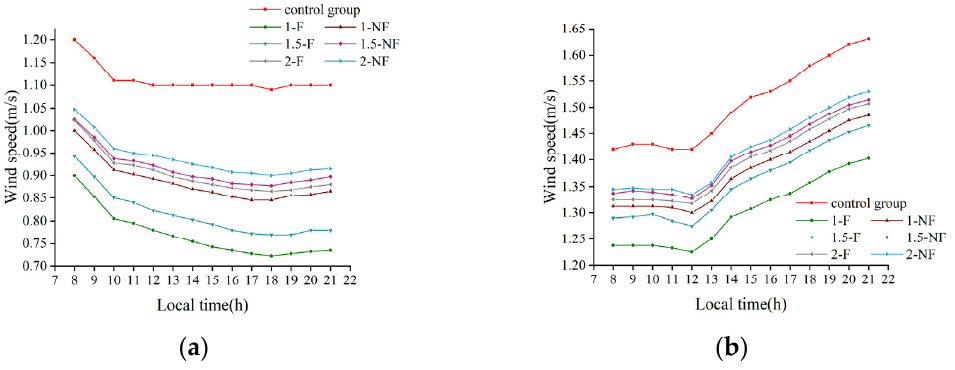
Figure 10. Effects of different arrangements of trees on wind speed in summer ( a ) and winter ( b ).